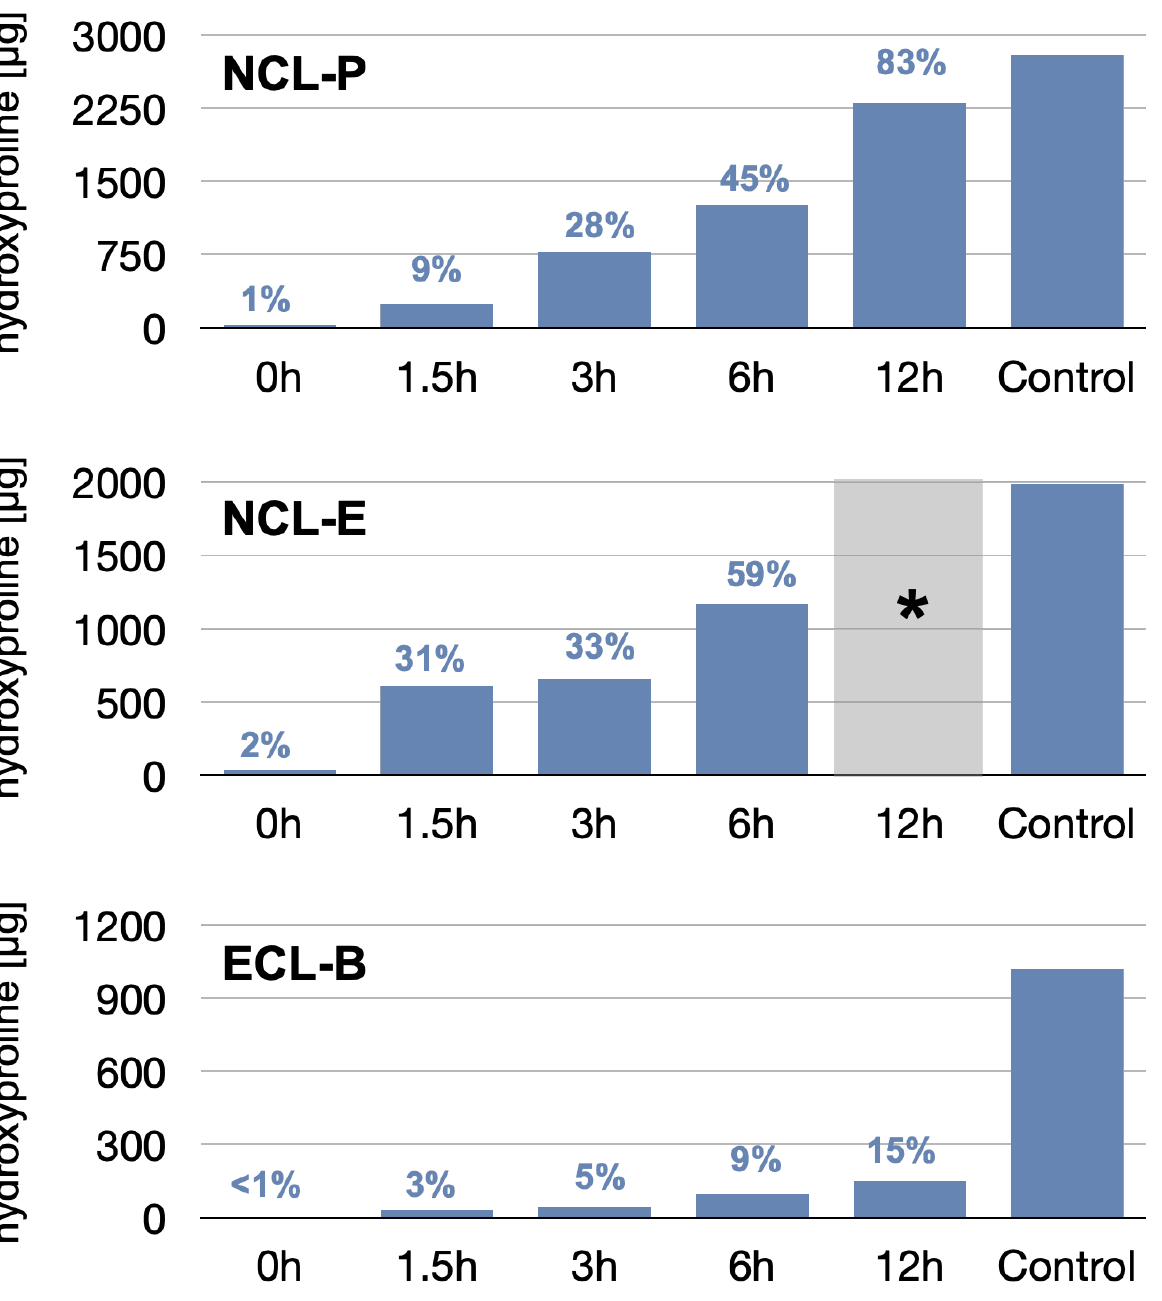
Figure 3. Results of the hydroxyproline (HP) concentration measured in the immersion/degradation solutions. Control values represent the potentially available HP concentrations determined in three completely dissolved control specimens of each material. The percentages represent the relative mean HP dissolution, with reference to the control, after different dissolution times. (* Note: No measurements could be performed for NCL-E after 6 h, as the membrane had completely disintegrated and was not usable).